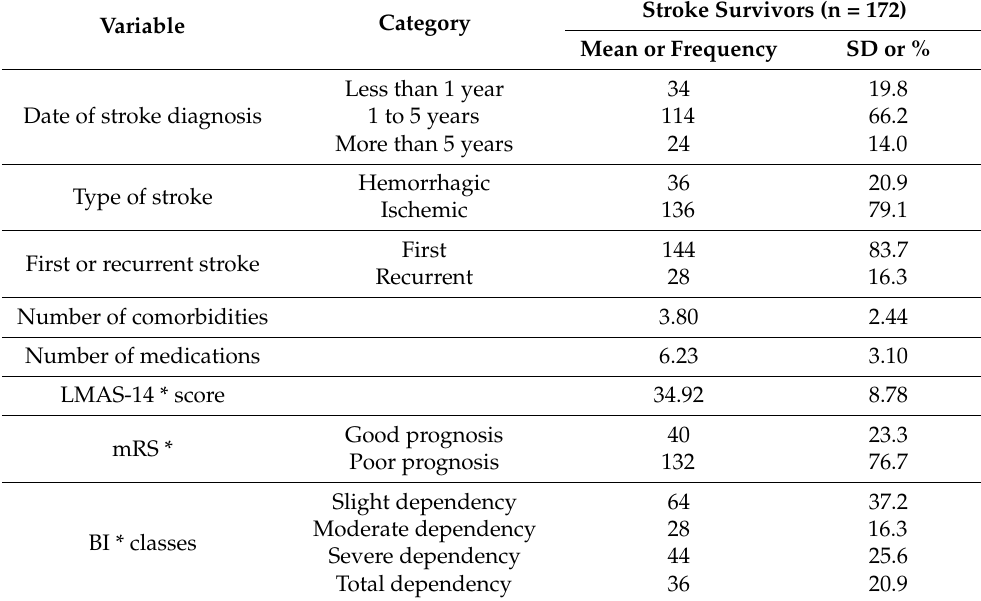
Table 2. Clinical characteristics of the